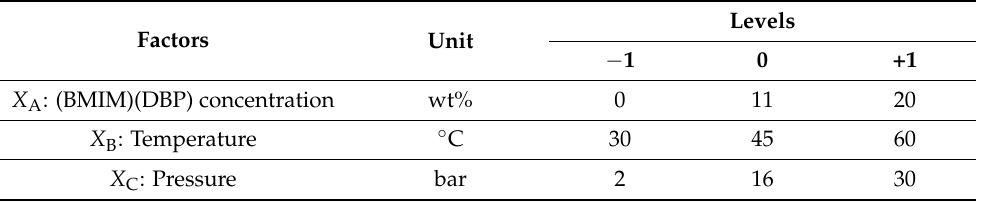
Table 1. Independent variables and concentration levels for response surface